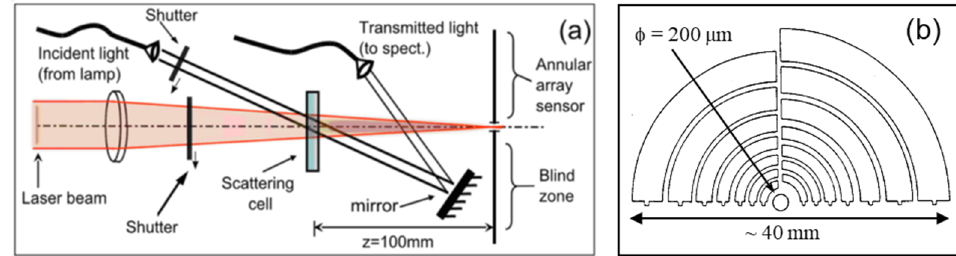
Figure 1. ( a ) Schematic diagram of the LALS + MWT setup. ( b ) Schematic diagram of the annular array sensor used for the LA-SLS measurements. Figure adapted from Ref.